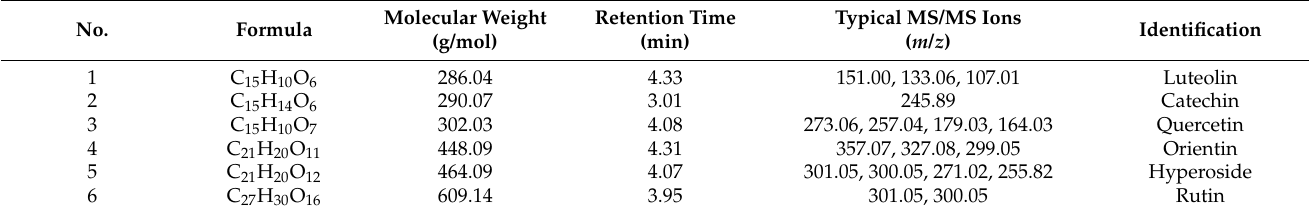
Table 2. Identification of compounds in lotus-leaf teas with different maturities in different process- ing